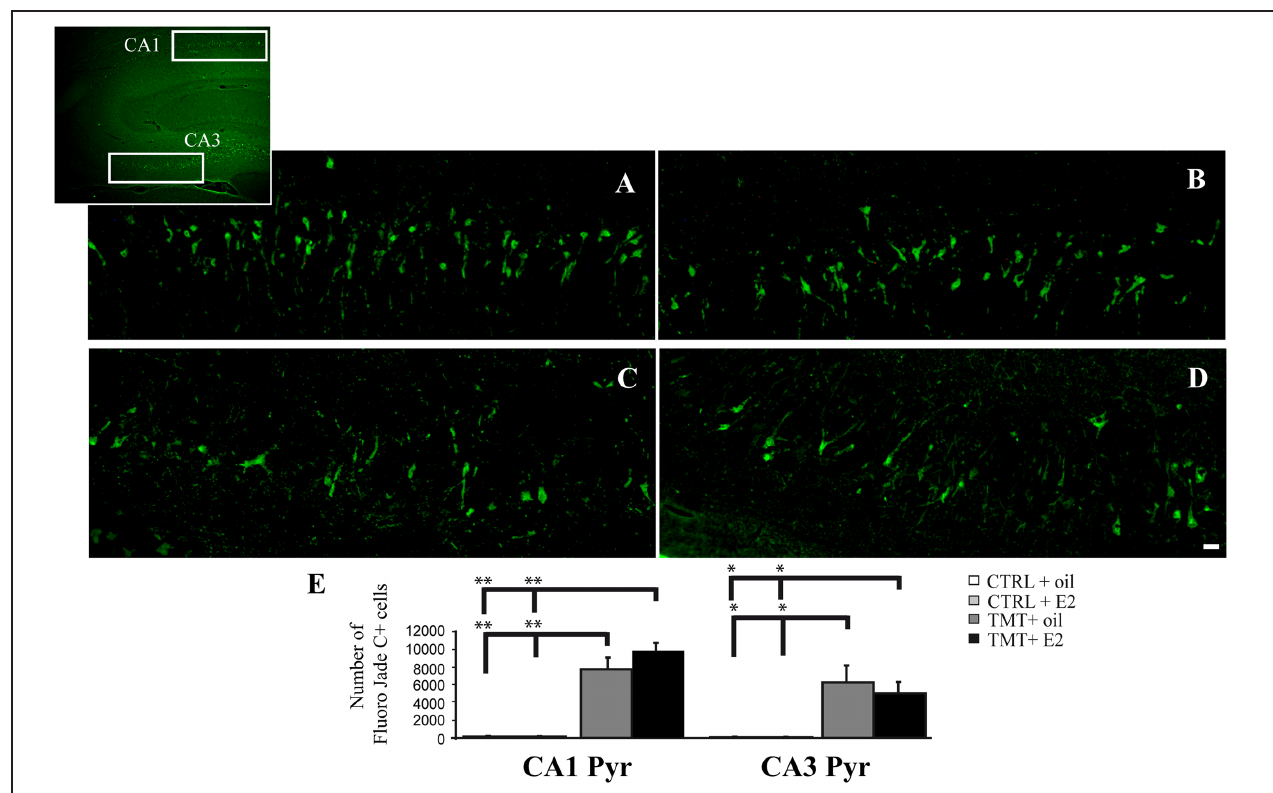
FIGURE 3 | Fluoro Jade C-stained degenerating neurons in the trimethyltin (TMT)-injured hippocampus. Representative micrographs of Fluoro Jade C-stained rat hippocampal sagittal sections from CA1 (A,B) and CA3 subfields ( C,D ; as indicated in the box) of TMT + oil- (A,C) , TMT + E2- (B,D) treated rats. Degenerating neurons are evident in both TMT + oil- and TMT + E2-treated animals. Scale bar: 60 μ m in (A–D) . (E) Bar graphs indicate quantitative analysis of Fluoro Jade C-stained neurons in CA1 and CA3 pyramidal cell layer of both TMT-treated groups. A significant difference in the number of Fluoro Jade C-stained cells is evident between TMT-treated rats and CTRL groups in both the CA1 and the CA3 regions, while no differences are detectable between TMT + oil- and TMT + E2-treated animals. The values are given as means ± SE ( ∗ p < 0.05, ∗∗ p < 0.001).